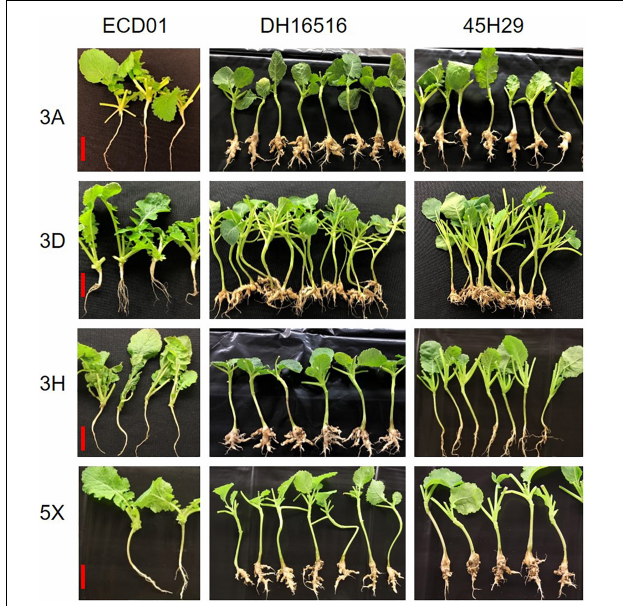
FIGURE 1 | Plant phenotypes and clubroot response at 5 weeks after inoculation in the parental lines (Debra and DH16516) and a control cultivar (45H29) to inoculation with four pathotypes (3A, 3D, 3H, and 5X) of Plasmodiophora brassicae under controlled conditions. The bars represent 5 cm in